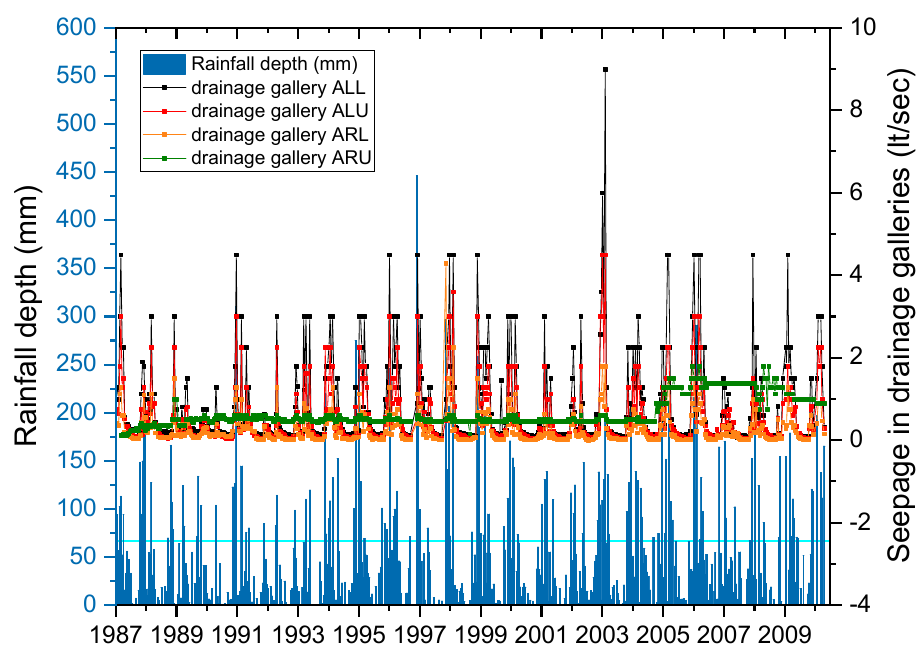
Figure 11. Left y-axis: rainfall depth between consecutive drainage measurement epochs. The light blue horizontal line corresponds to the threshold of 67 mm, above which a direct correlation between rainfall depth and seepage volume is observed. Right y-axis: Seepage recorded in the drainage galleries of the Pournari I dam.